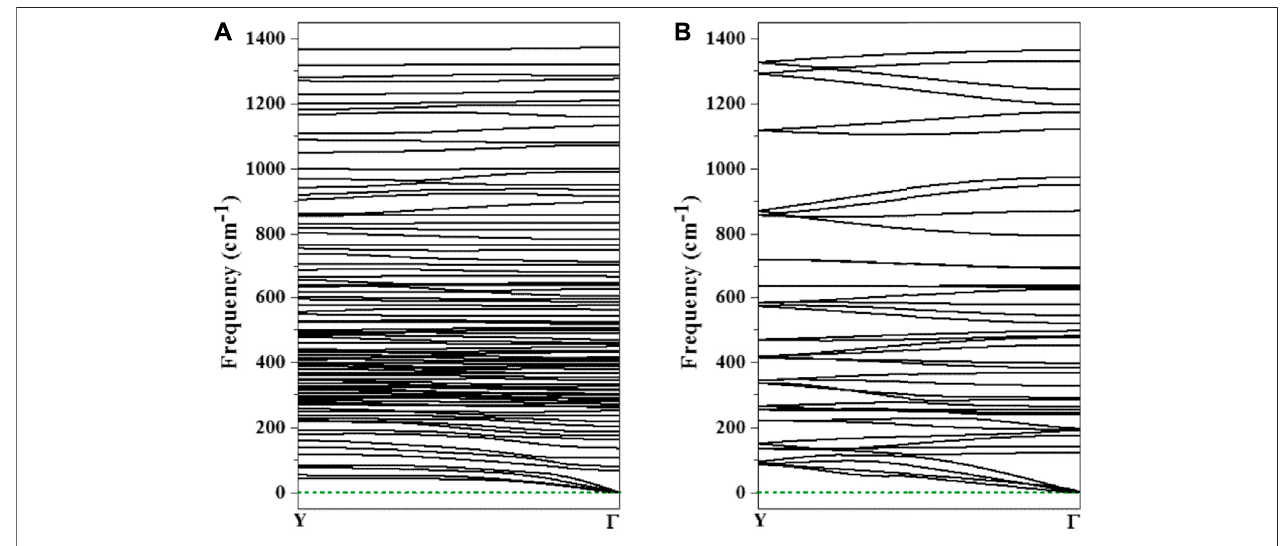
FIGURE 3 | The calculated phonon spectra of the designed 1D-Sc 4 B 24 (A) and 1D-Y 2 B 12 (B) .